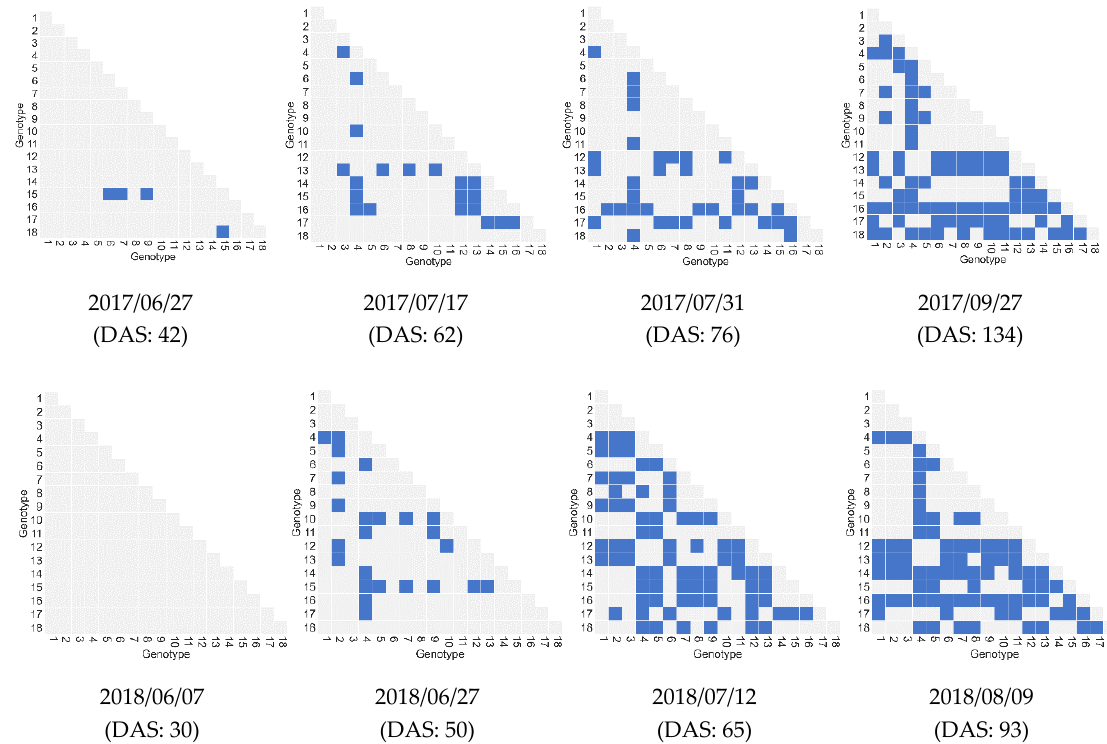
Figure 3. Ground reference data collected during the 2017 and 2018 growing seasons in the HyCal panels. For each variety, the data samples are sorted based on the day after sowing (DAS).